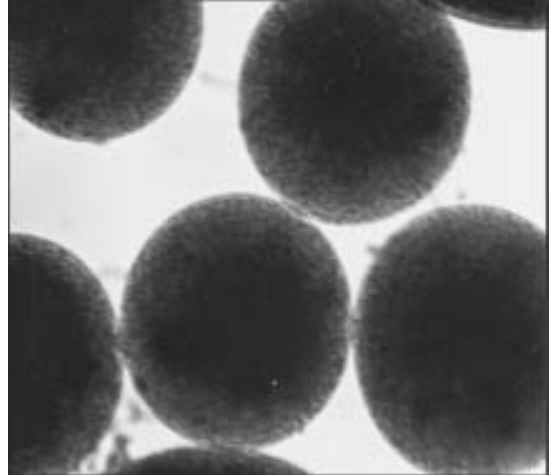
Figure 1 Photomicrograph of alginate beads containing immobilized Lactobacillus plantarum 80 (pCBH1) cells at 175 ×